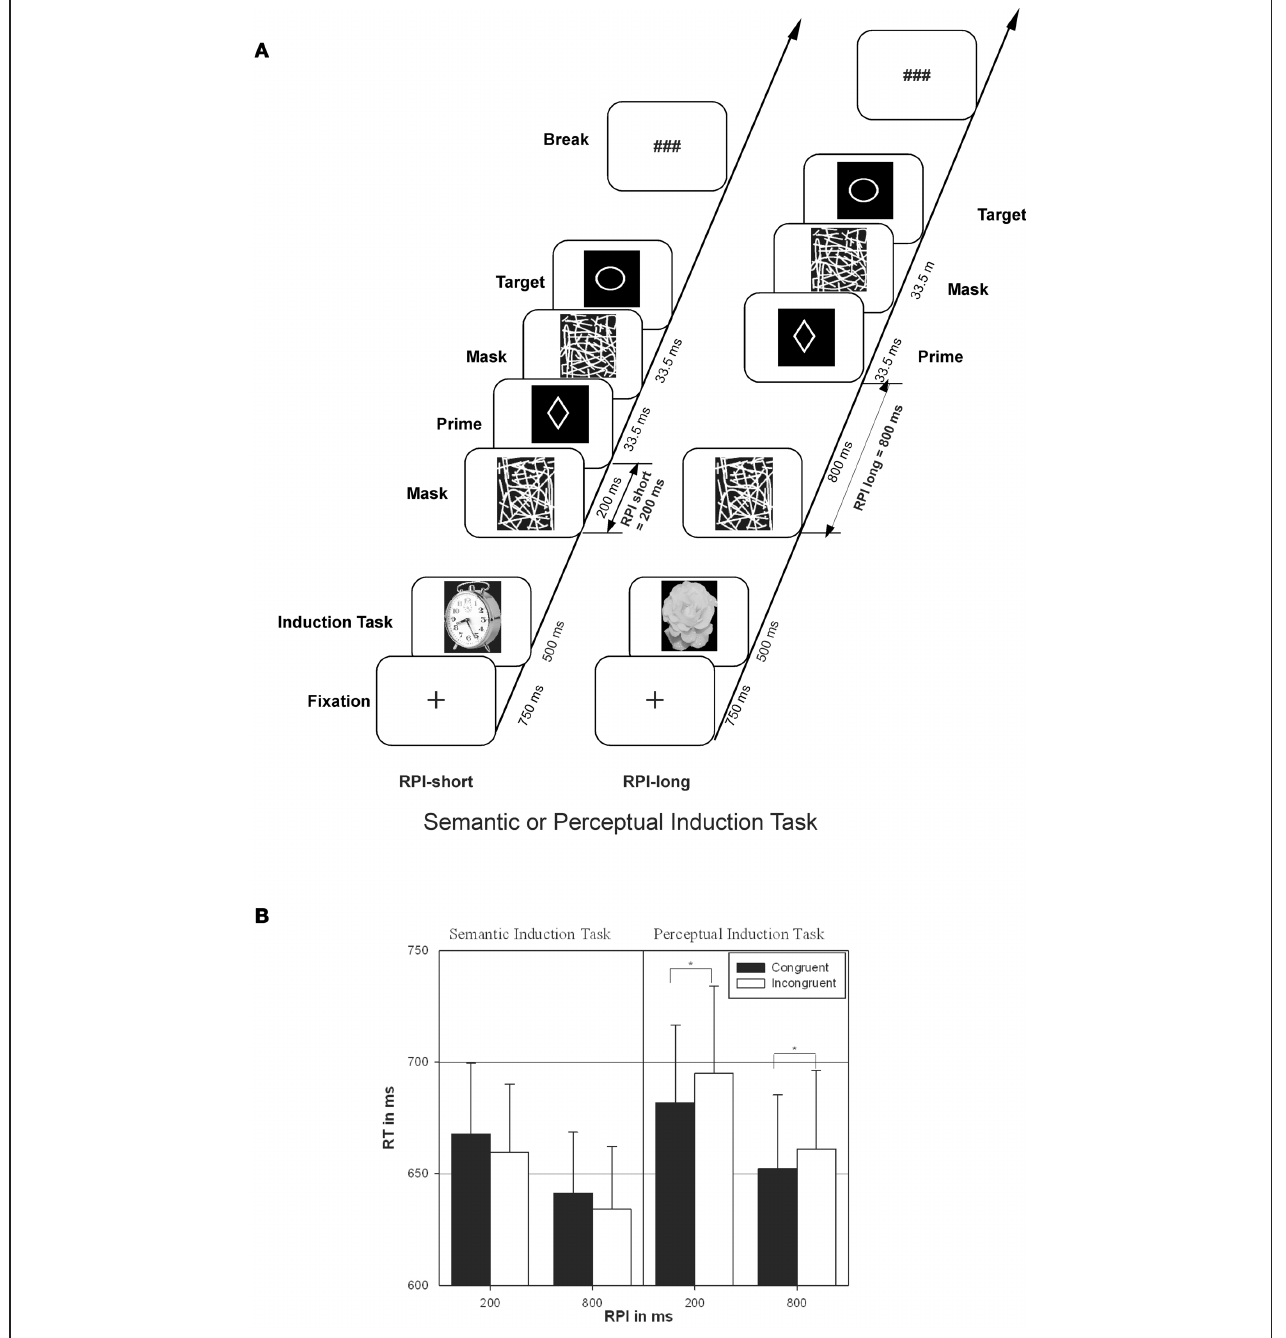
target shape afforded the same manual response whereas in the incongruent condition, prime and target were associated with different response hands. (B) Behavioral unconscious visuo-motor priming effects of Exp. 2 of the Martens et al. (2011) study. Mean correct response times and their standard error in the target shape discrimination task, as a function of response congruency, induction task, and RPI. The asterisks indicate significant masked priming effects (difference between incongruent and congruent prime-target responses) within each induction task/RPI combination. Significant unconscious visuo-motor priming effects were only obtained following the perceptual induction task, but not following the semantic induction task. Modified after Kiefer and Martens (2010) and after Martens et al.